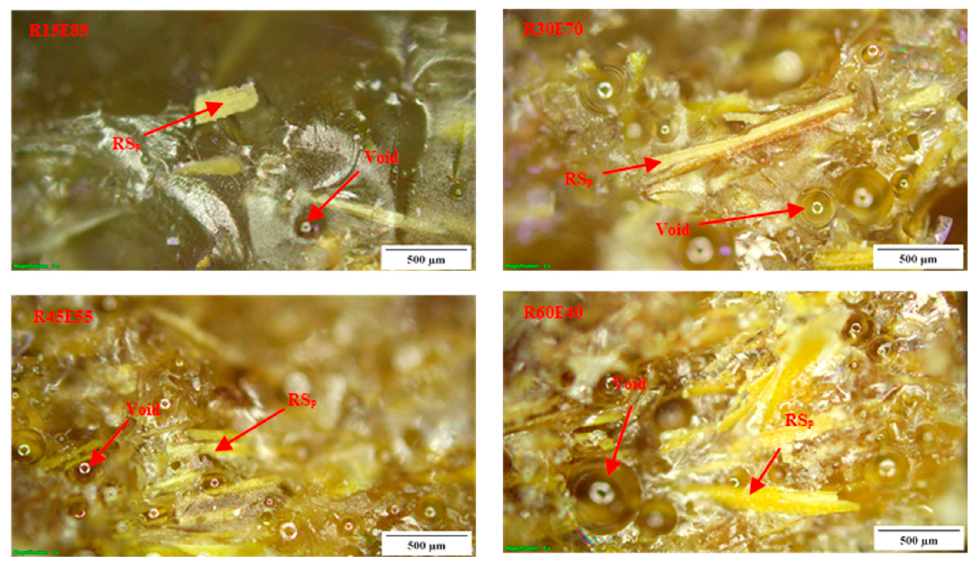
Figure 13. Tensile load-fractured surfaces of test samples.